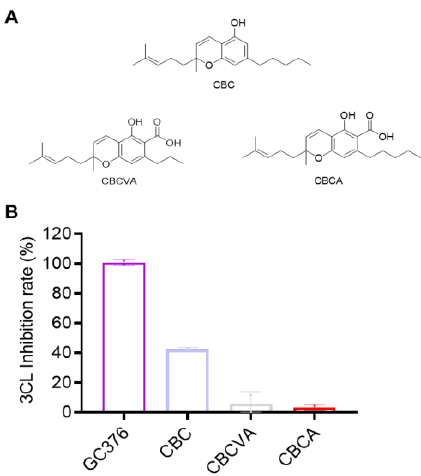
Figure 4. The chemical structures of the CBC-type of cannabinoids ( A ) and their inhibitory effect on the activity of SARS-CoV-2 M pro ( B ). These cannabinoids were tested at a concentration of 10 μM with the MBP-tagged SARS-CoV-2 M pro inhibition assay. GC376 was used as the positive control and each test compound was assayed in triplicate.